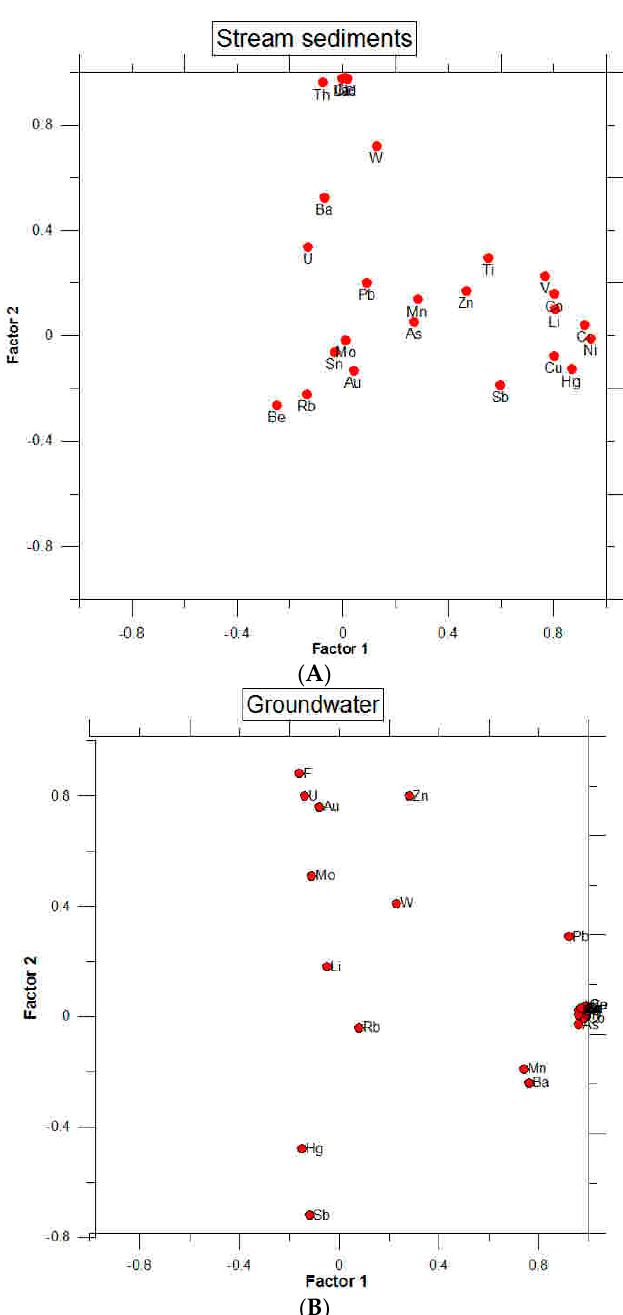
Figure 7. Factorial diagram for sediments ( A ) and groundwater ( B ).